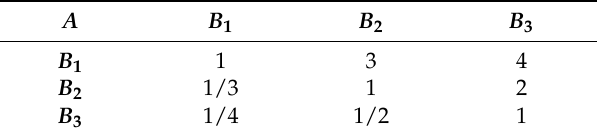
Table A1. Judgment matrix of A – B .